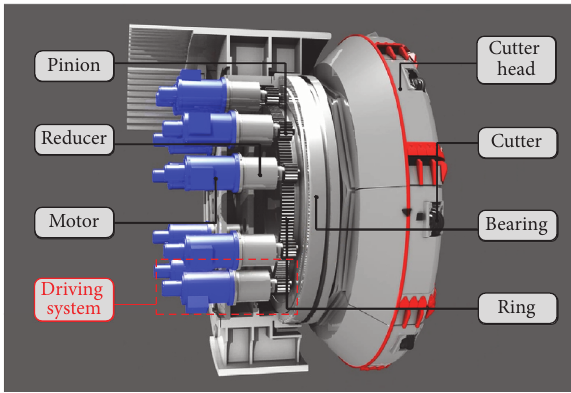
Figure 1: Cutterhead driving system in